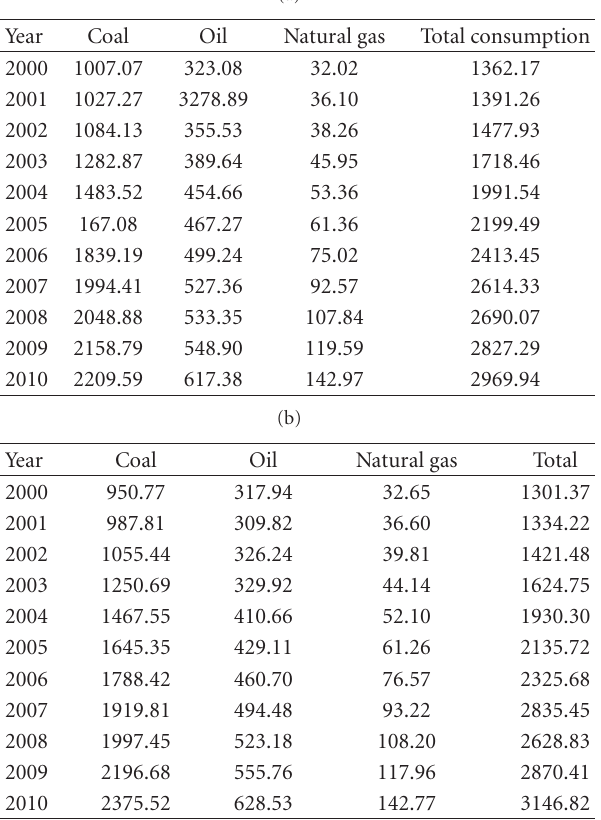
Table 3: (a) The fossil fuels’ consumption from 2000 to 2010 in China (unit: million tsc). (b) The fossil fuels’ supply 2 from 2000 to 2010 within China (unit: million tsc).